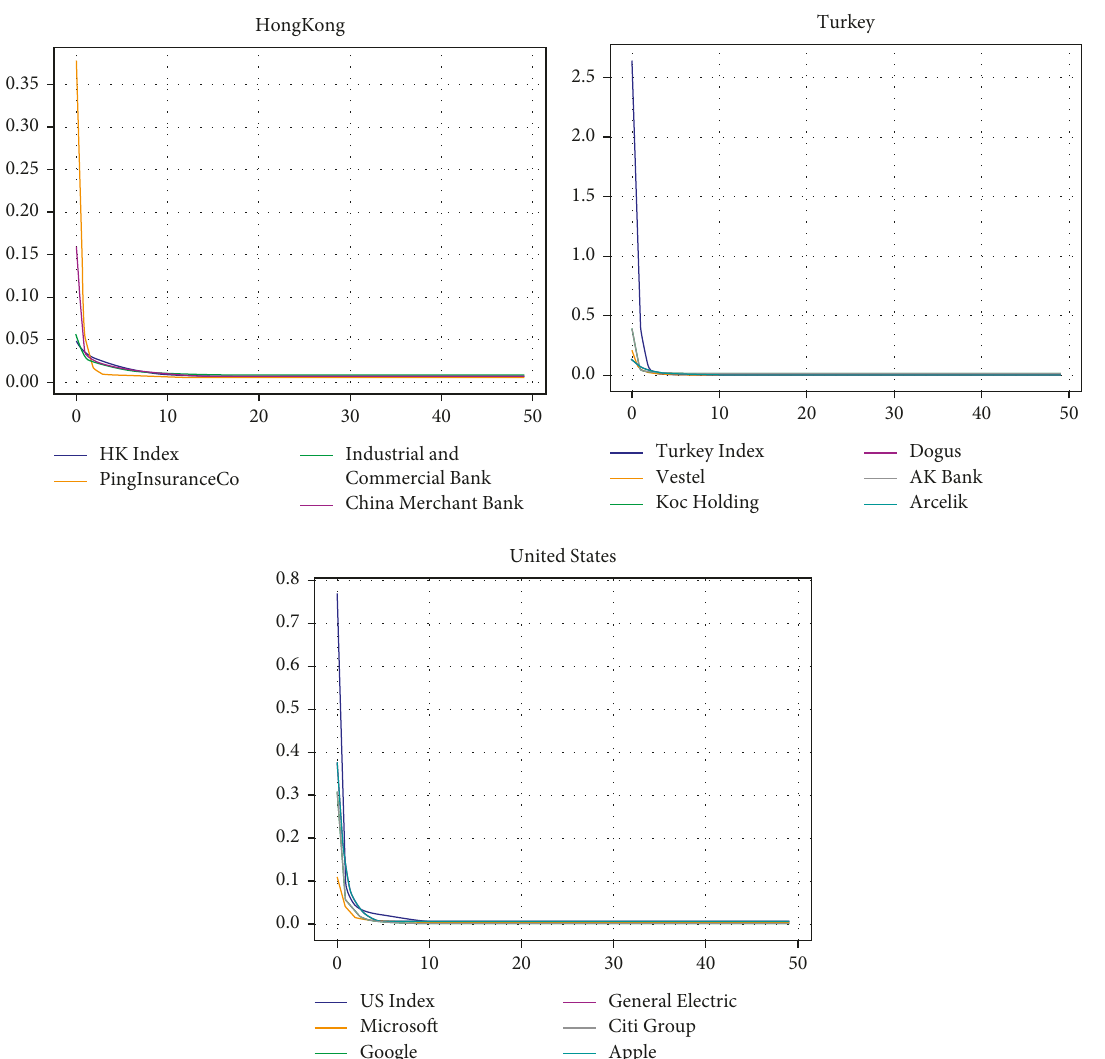
Figure 4: Training loss curves of the companies of different countries including Hong Kong, Turkey, and the United States with